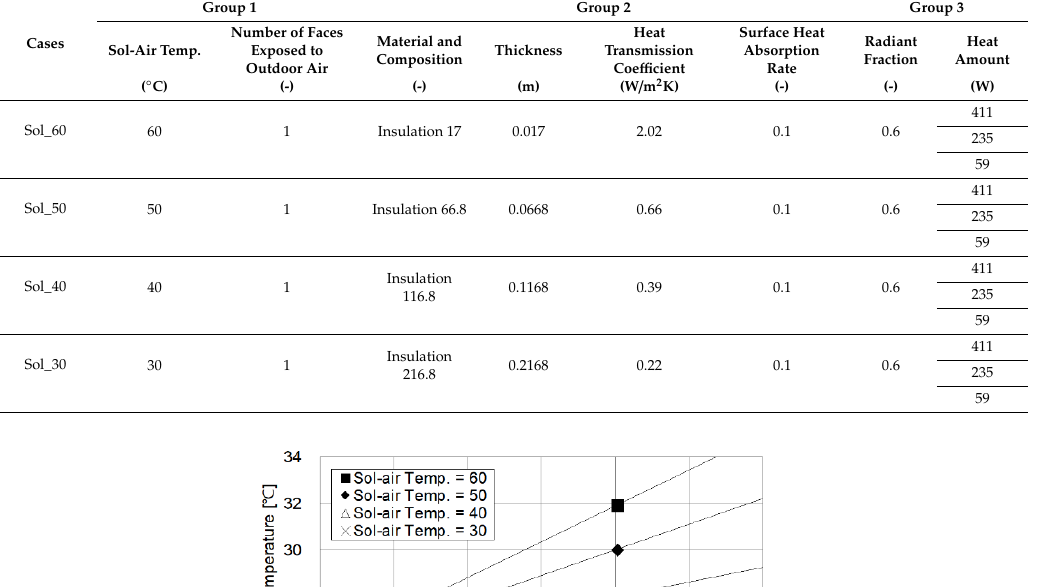
Table 12. Cases for sol-air temperature.